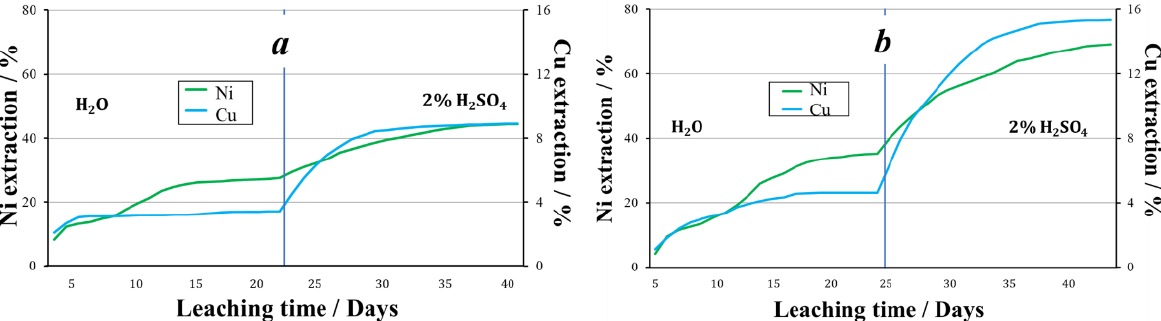
Figure 8. The extraction of metals during leaching of granules prepared using various oxidizing agents followed by storage at below 0 °С ambient temperatures, ( a ) — 2% H 2 SO 4 + Fe 3+ , ( b ) — 2% H 2 SO 4 + NO 2 − .